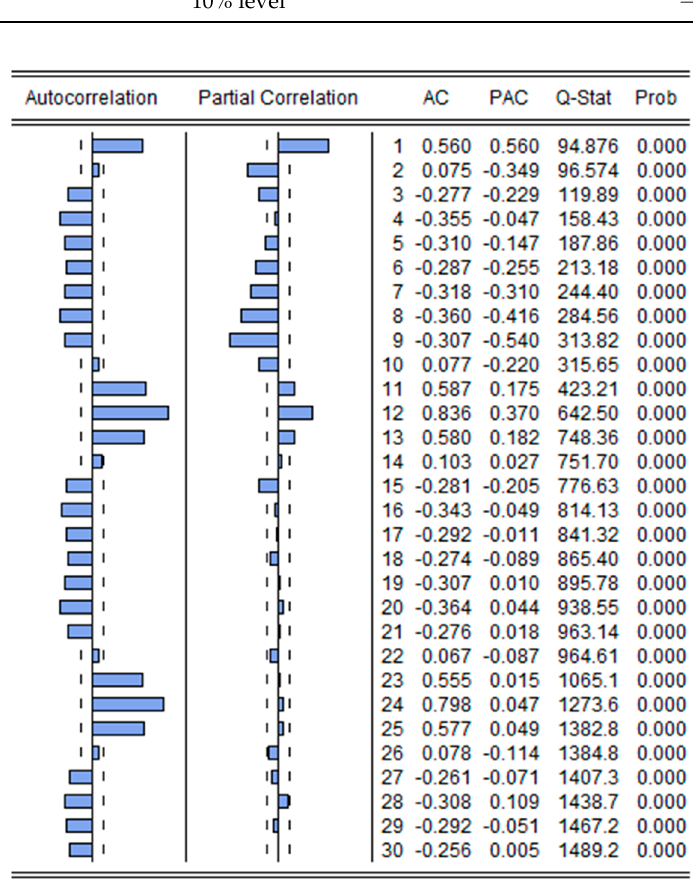
Figure 2. Depiction of ACF and PACF values of the temperature series.